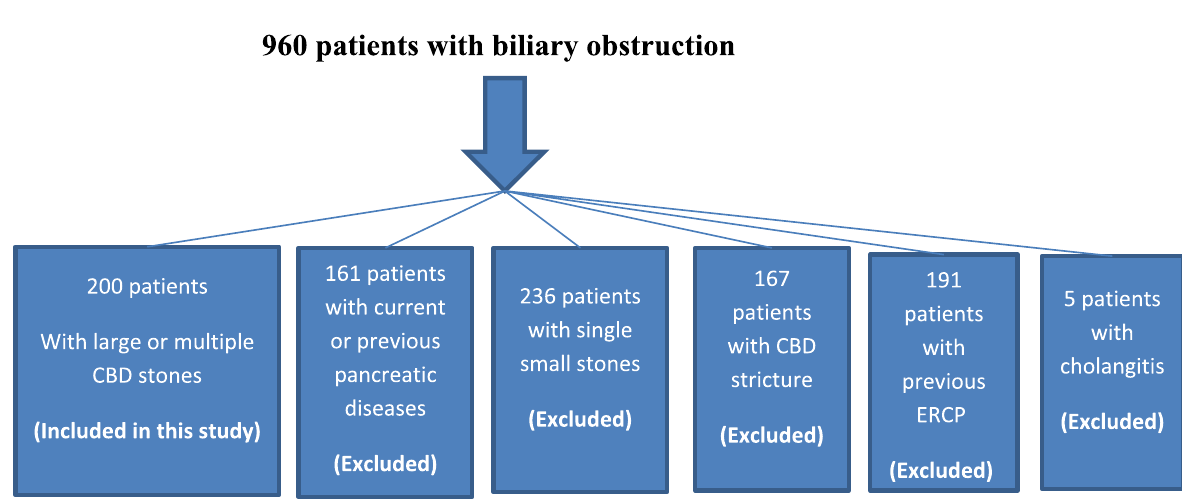
Fig. 1 Inclusion and exclusion criteria of studied